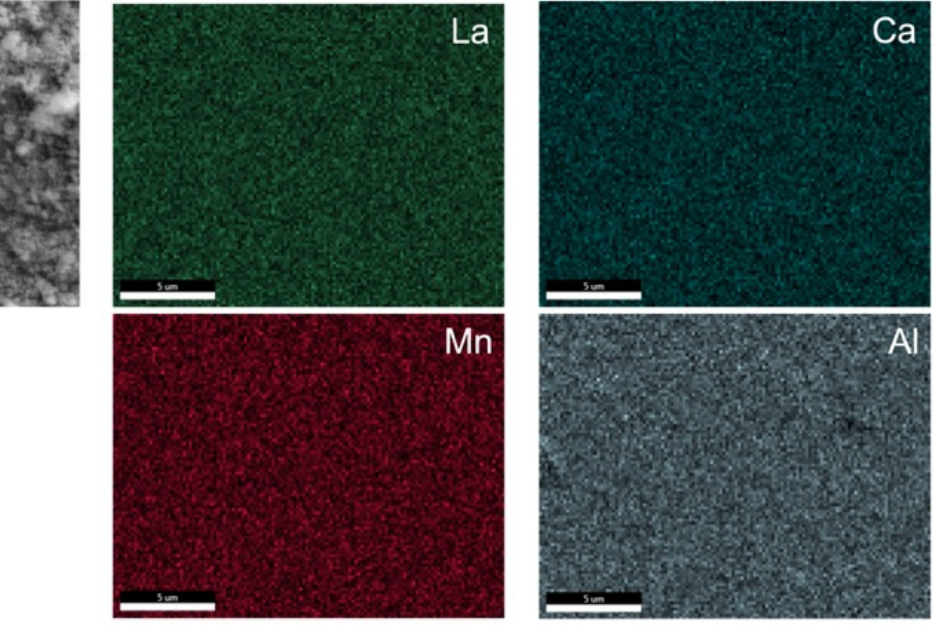
Figure 9. SEM and EDS mapping for La, Ca, Mn, and Al of the LCMA powder showing homogeneous distribution.